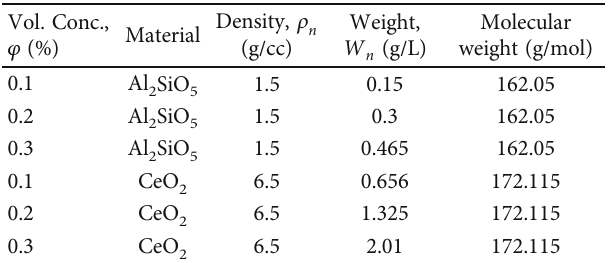
Table 1: Volume concentration values with respective